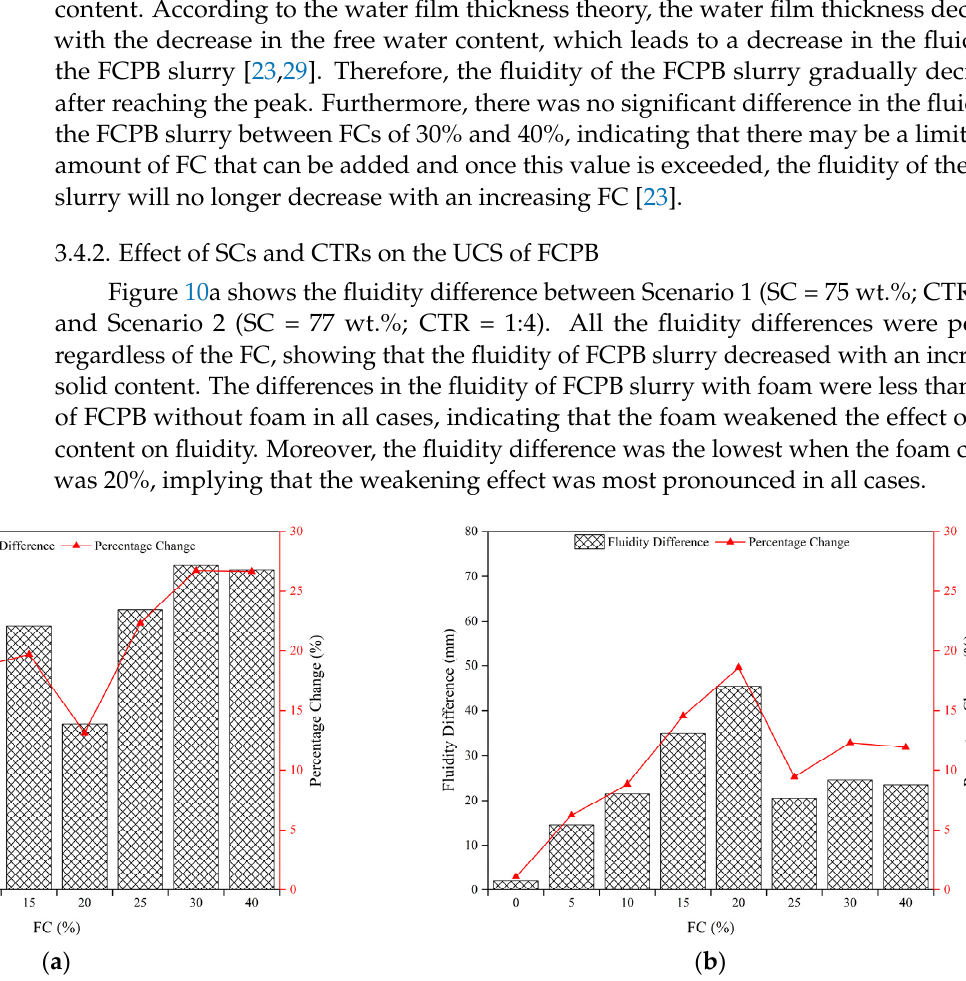
Figure 10. Relationship between the FC and the differences in the fluidity of FCPB: ( a ) CTR = 1:4 and ( b ) SC = 77 wt.%.